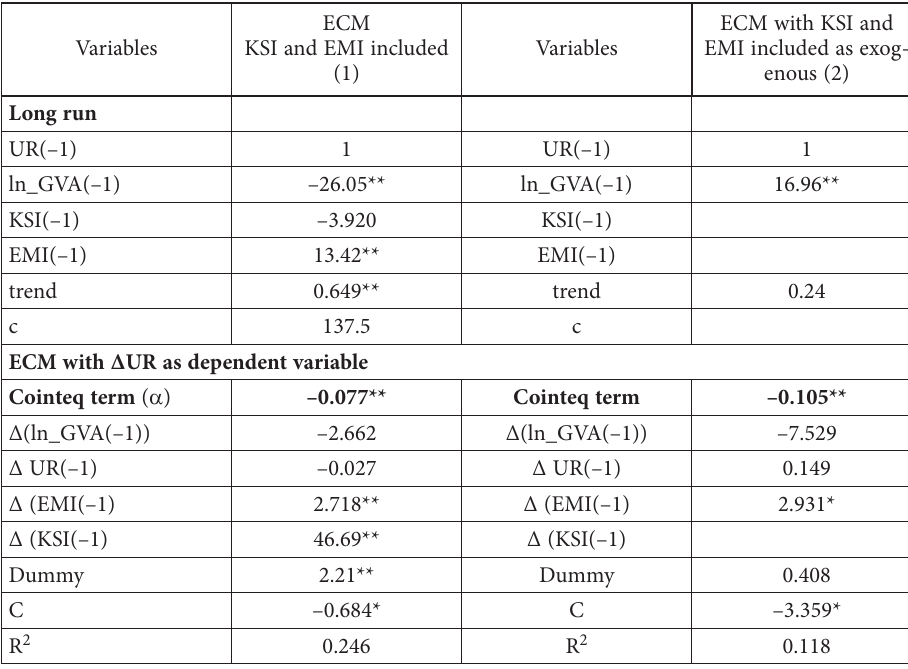
Table 6. Panel Data Analysis results for Mining and quarrying; Electricity, gas and water supply (MIN) ECM ECM with KSI and Variables KSI and EMI included Variables EMI included as exog- (1) enous